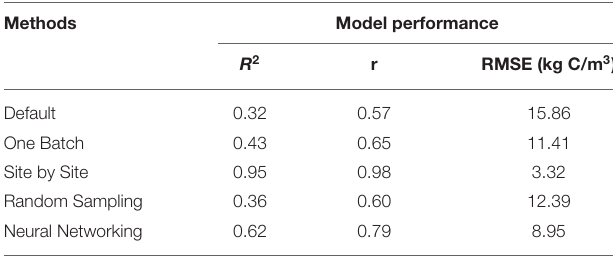
TABLE 1 | Performance of CLM5 in representing SOC distribution under different